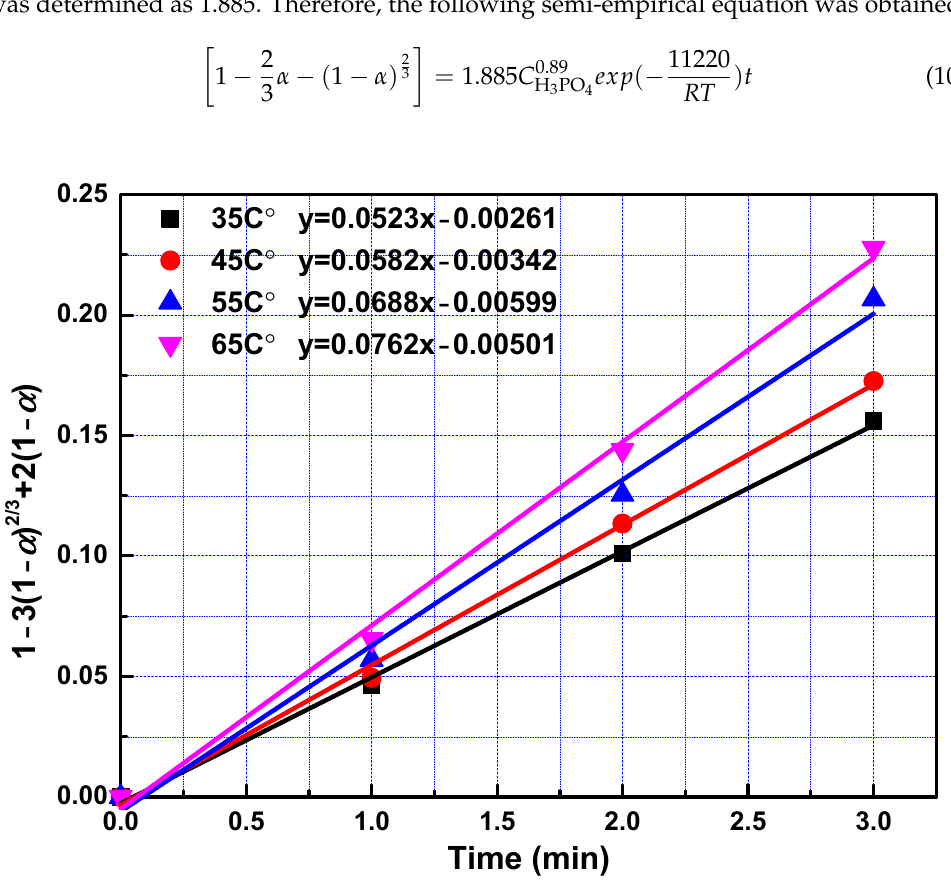
Figure 5. The relationship between 1 − 3(1 − α ) 2/3 + 2(1 − α ) and leaching time during the fast reaction stage at a different temperature.